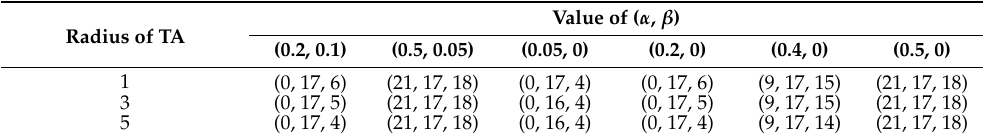
Table 4. The valid numbers of areas expressed in Table A5, and the three numbers in brackets correspond to areas labeled “L”, “Y”, “N”,